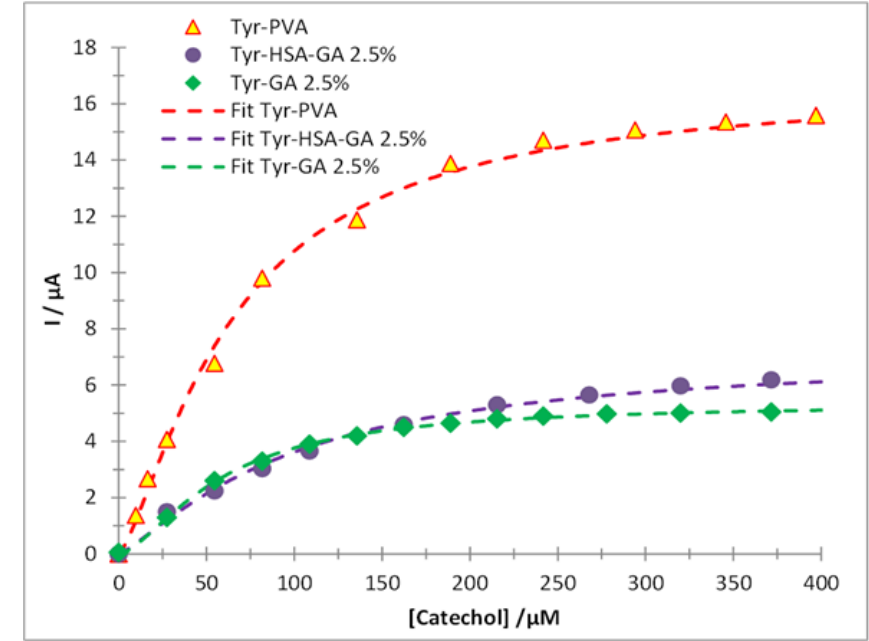
Figure 4. Comparison of the enzymatic kinetics for catechol (dots) recorded using the different tyrosinase biosensors: (  ) SPE/Tyr/PVA (  ) SPE/Tyr/HAS/GA and (  ) SPE/Tyr/GA in acetates’ buffer 0.1M at pH 4.50 ± 0.01 a (30.0 ± 0.5) °C. Following the measured current, at –300 mV imposed potential, as a function of catechol’s concentration. The lines correspond to the fitting of the Hill’s model of Equation (1), the best fit values for K ′, I and h are shown in Table m max